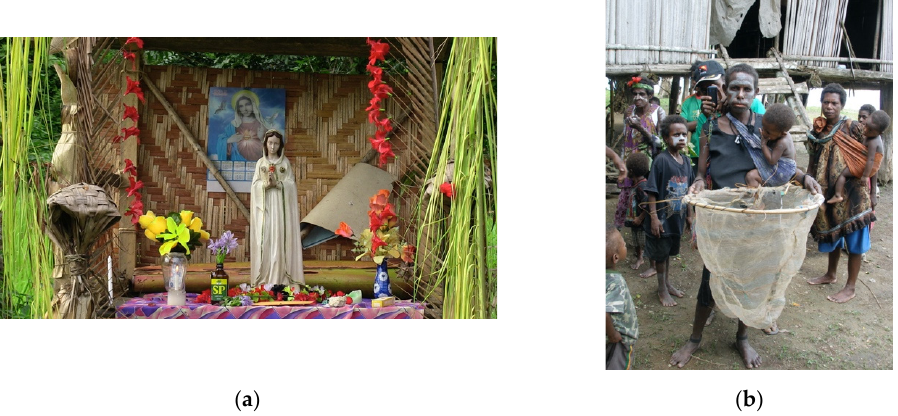
Figure 2. ( a ) Timbunmeli’s statue of Mother Mary (photo: Falck 2013); ( b ) A Nyaura woman during a celebration with a contemporary version of the net that two ancestral sisters had caught wagen with while fishing for shrimps (photo: Falck 2013).